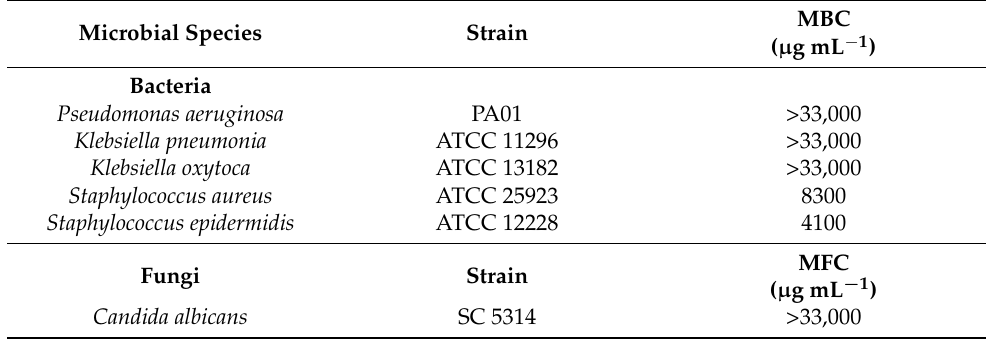
Table 4. MBC and MFC performance of S. nigra flower aqueous extract against pathogenic organ- isms.